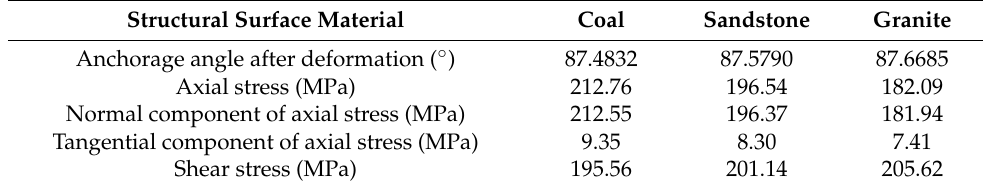
Table 5. The stresses under the local action of the bolt yield.